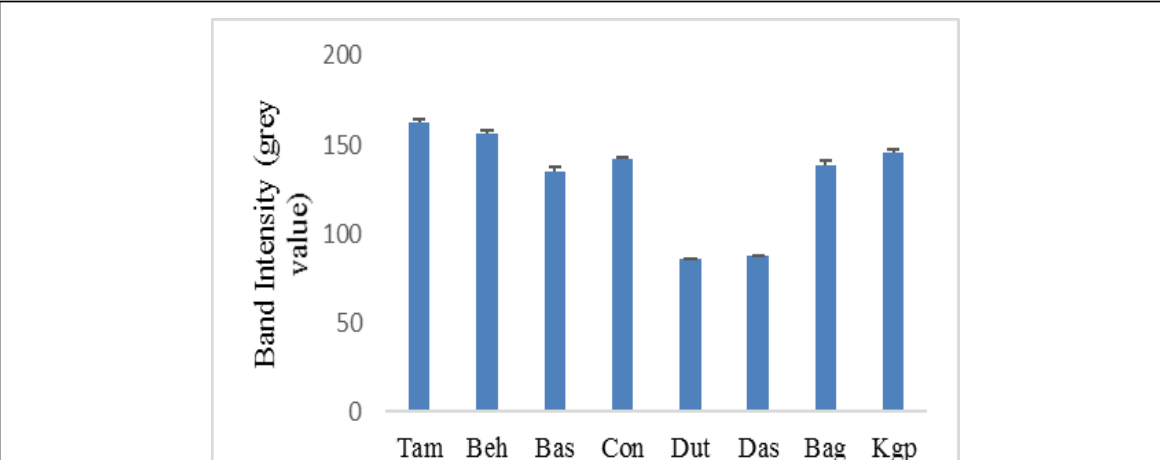
Figure 6: Agarose gel electrophoresis of (a) McSQS and (b)  -actin